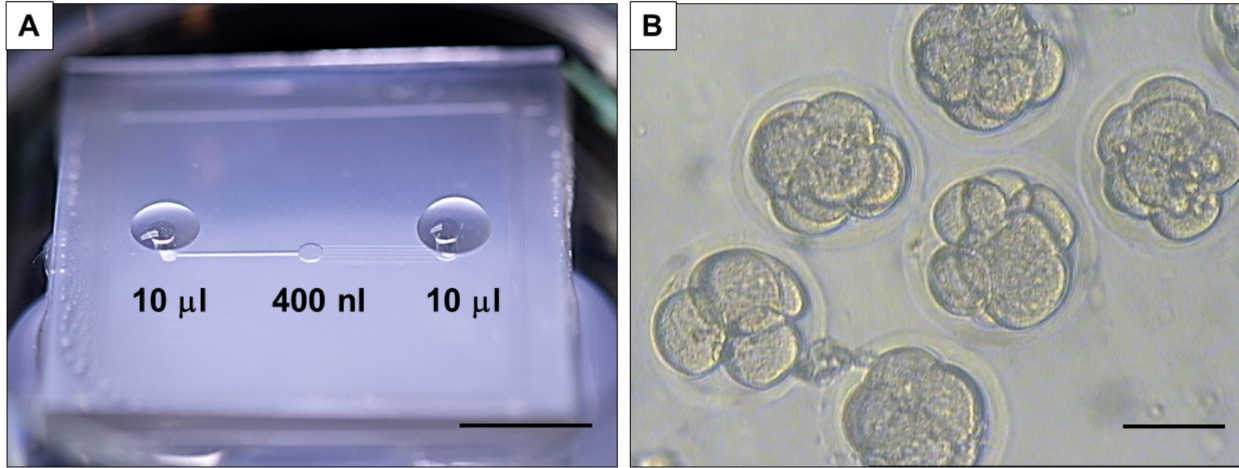
Figure 1. Microfluidic device. ( A ) The device is placed in a 60 mm petri dish for loading medium and kept in the incubator for the duration of the culture (scale bar 1 cm). ( B ) The developing embryos visualized in the central chamber in brightfield (scale bar 100 µ